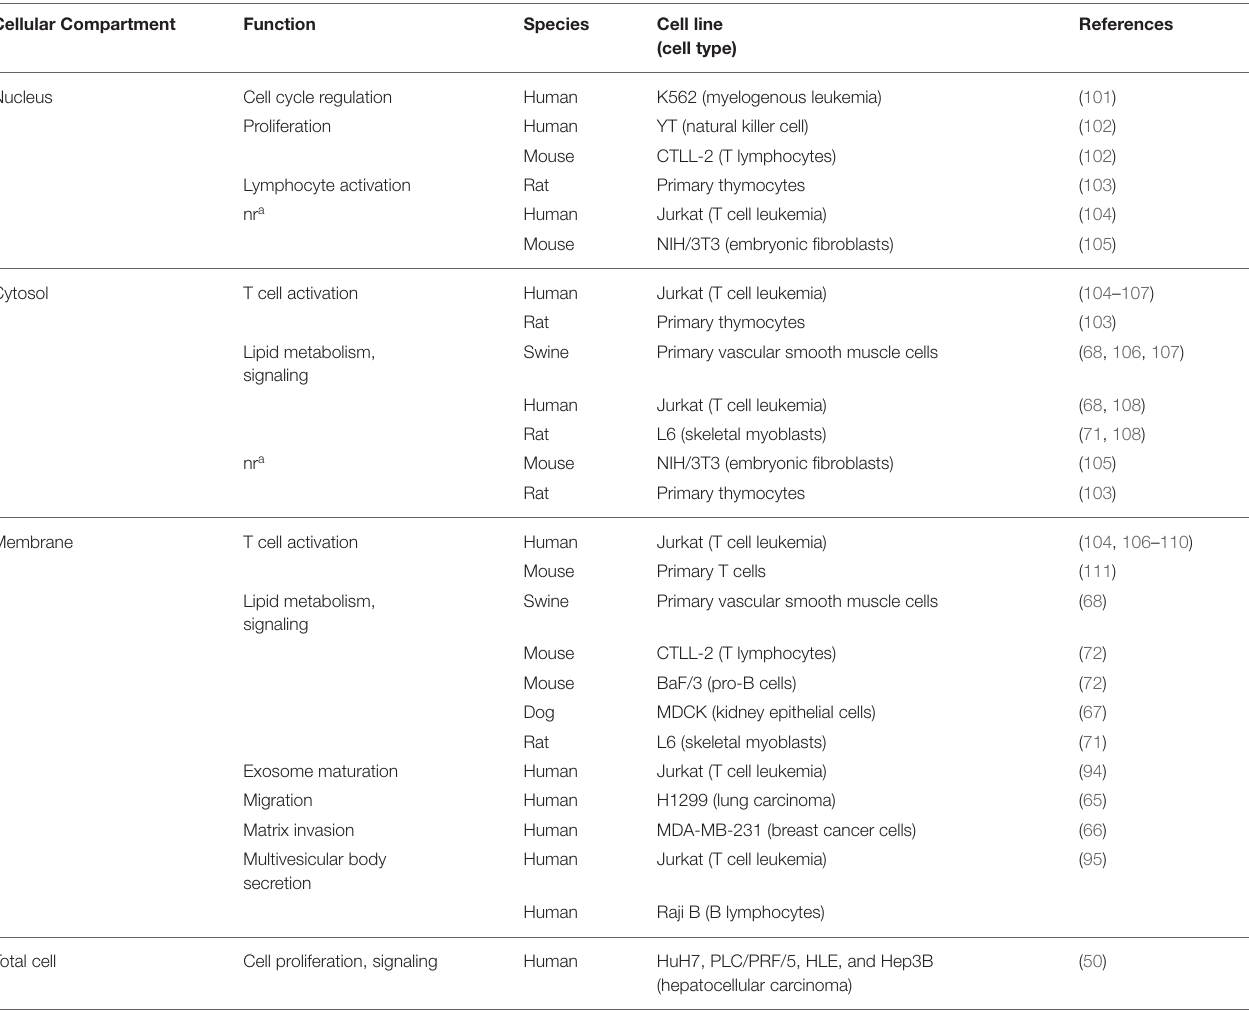
TABLE 1 | DGKA function according to cellular